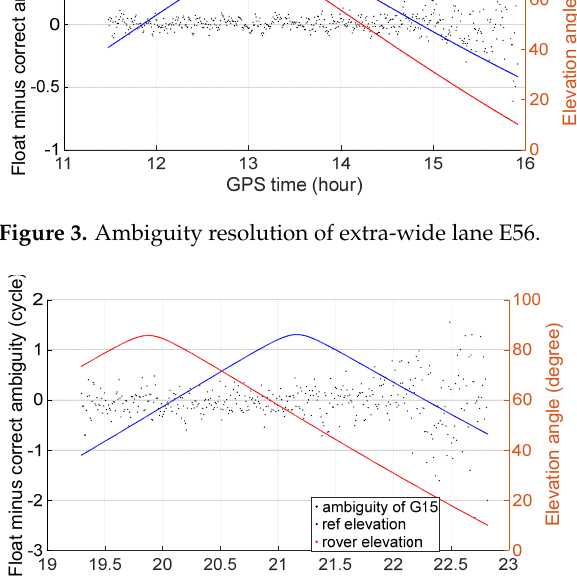
Figure 3. Ambiguity resolution of extra ‐ wide lane E56.